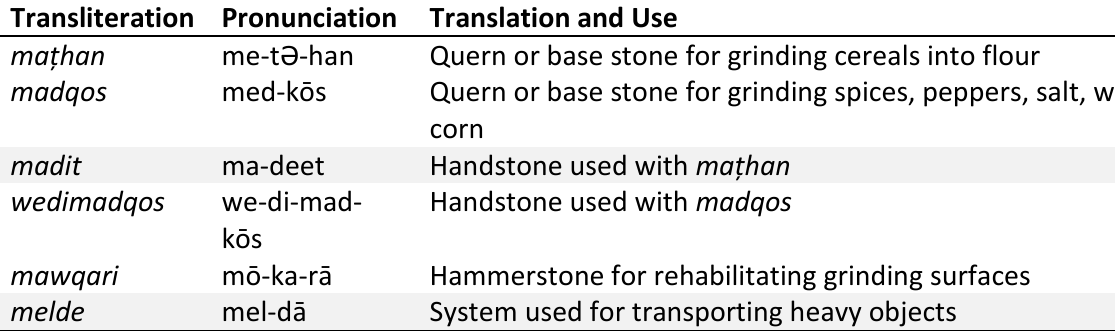
Table 1. Tigrinya terms. Note: Transliterations for many Tigrinyan terms were provided by Professor Yaqob Beyene, Professor Emeritus, Department of Asia, Africa, and the Mediterranean, University of Naples, and additional Tigrinyan terms were translated by Yemane Maresa and Habtamu Mekonnen Taddesse. Pronunciations are as were heard orally in